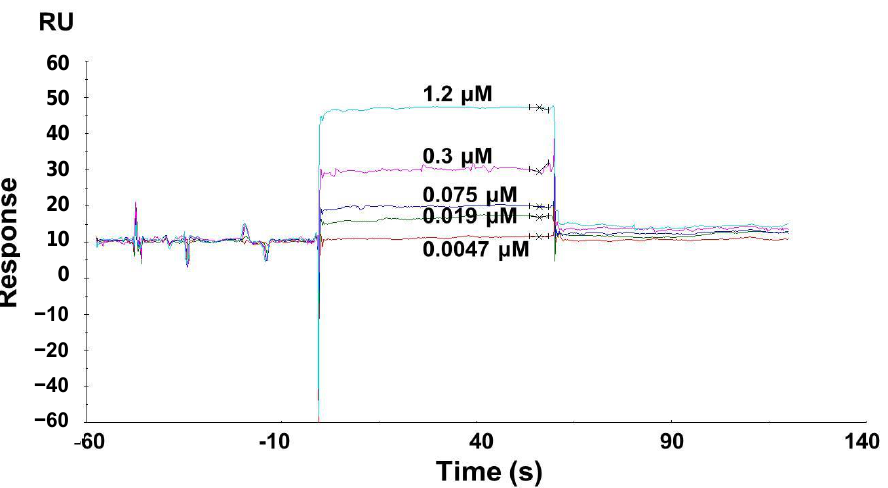
Figure 5. The affinity between LF and the NT5DC3 protein, determined via SPR. This experiment was repeated three times ( n = 3).